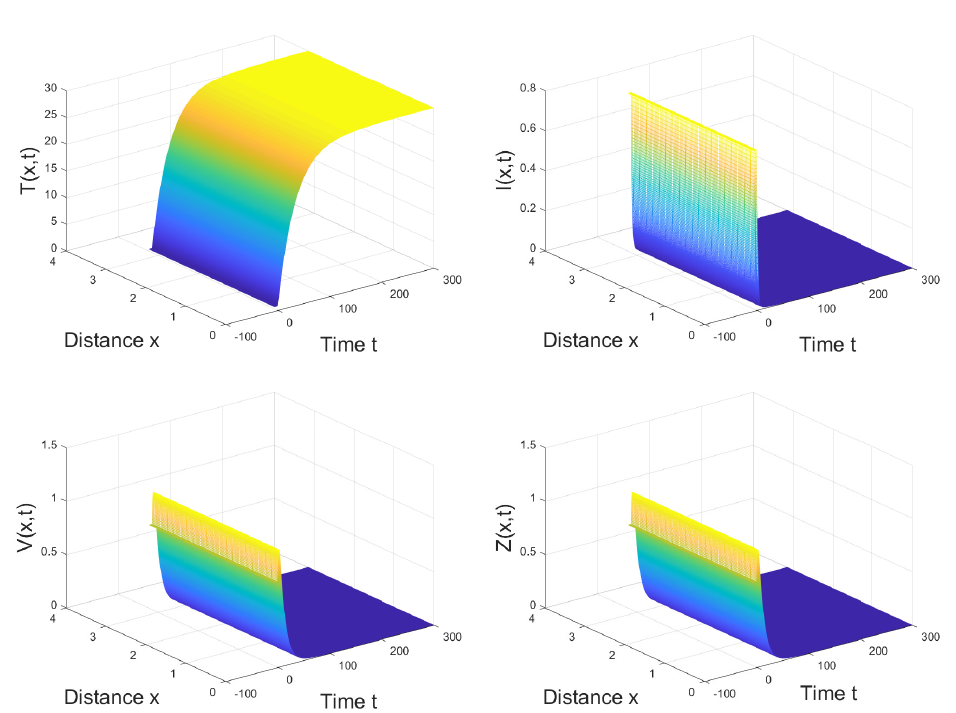
Figure 2. When D = 3, R 0 < 1, the infection-free equilibrium E 0 is globally asymptotically stable.